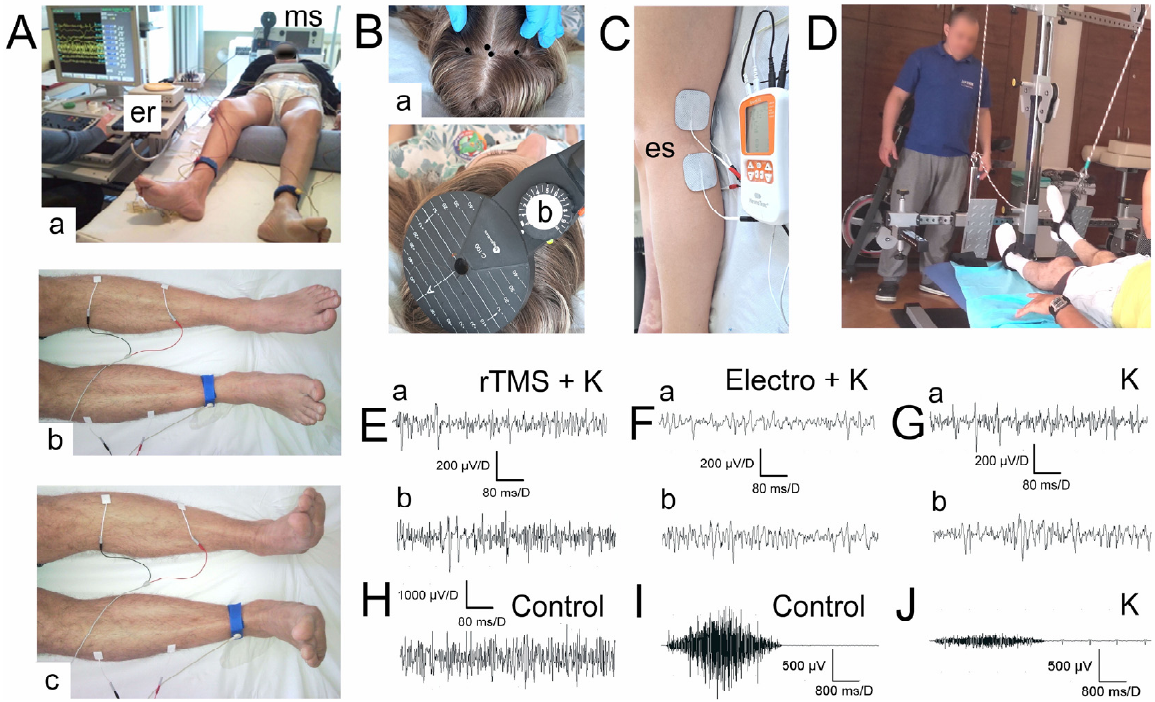
Figure 1. Photographs illustrating methodological principles of sEMG recordings ( A ): (a) electromyography recorder “er” and the magnetic stimulation device “ms”; (b) bilateral location of sEMG bipolar surface electrodes during recordings from tibialis anterior muscles at rest; (c) sEMG recording during the attempt of 5 s lasting muscles maximal contraction and applied therapies in five groups of iSCI patients. ( B ) rTMS or rTMS + K—groups of patients treated with rTMS and additionally with kinesiotherapy: (a) marking of the “hot spots” for repetitive transcranial magnetic stimulations; (b) location of coil during releasing the trains of stimuli from the magnetic stimulation device “ms”. ( C ) Electro or Electro + K—groups of patients treated with electrotherapy and additionally with kinesiotherapy (“es”)—bipolar electrode placement and the device for functional electrical stimulation during nerves electrotherapy. ( D ) K—patients treated with kinesiotherapy only (system for lower extremities strengthening exercises with loadings is shown). ( E – G ) Examples of sEMG recordings from anterior tibialis muscles during the attempt of maximal contraction in patients belonging to three studied groups before (a) and after (b) therapies. sEMG recording from one of the healthy volunteers is shown in ( H ) for comparison. ( I , J ) Examples of sEMG recordings presenting 5 s lasting maximal contraction with a slower time base in one of the subjects from the control group and a patient from the ( K ) group, respectively. Calibration bars for different amplifications and time bases are presented.